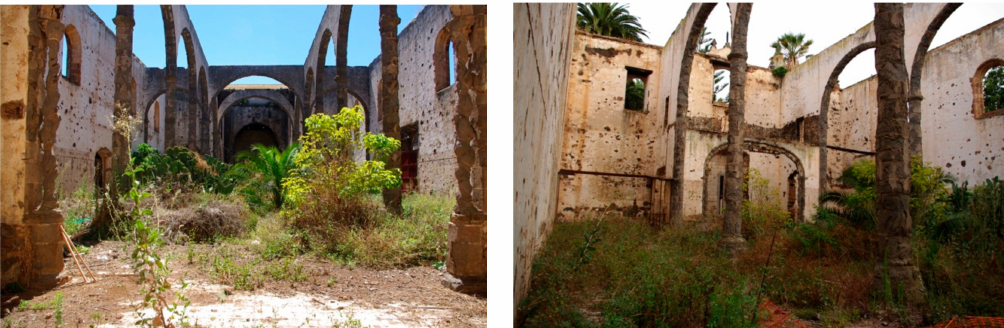
Figure 1. Current state of disrepair of the St Augustine